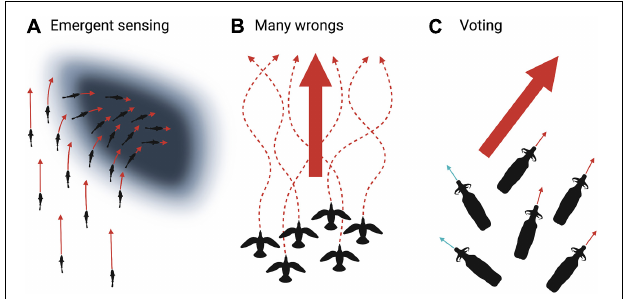
FIGURE 8 | Illustrated examples of collective decision-making strategies. (A) Emergent sensing in which individuals respond to environmental gradients (e.g., golden shiners increase swimming speed as a function of light) and social cues (e.g., responding to movement of neighbors). This results in collective navigation toward favorable dark areas. (B) Many wrongs in which the collective pooling of estimates suppresses individual error (e.g., indirect homing routes in pigeons; dashed arrows) and increases collective navigational accuracy (large arrow). (C) Voting occurs when individuals express their preference for initiation or direction of movement (e.g., African buffalo orienting toward a proposed movement path; small blue and red arrows). Voting prompts the group to choose the majority (large red arrow) or average the proposed paths. Created with